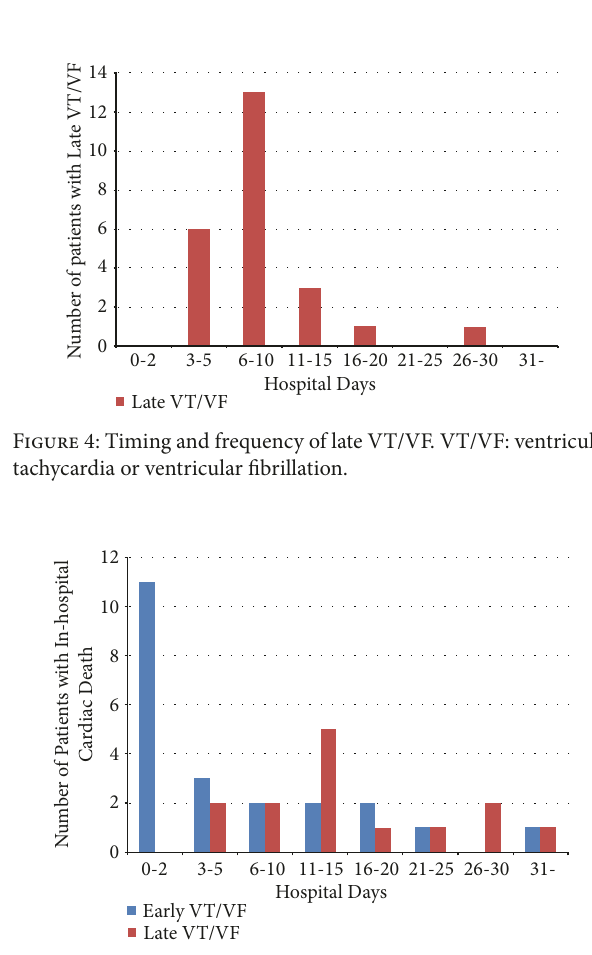
Figure 5: Timing and frequency of in-hospital cardiac death. VT/VF: ventricular tachycardia or ventricular